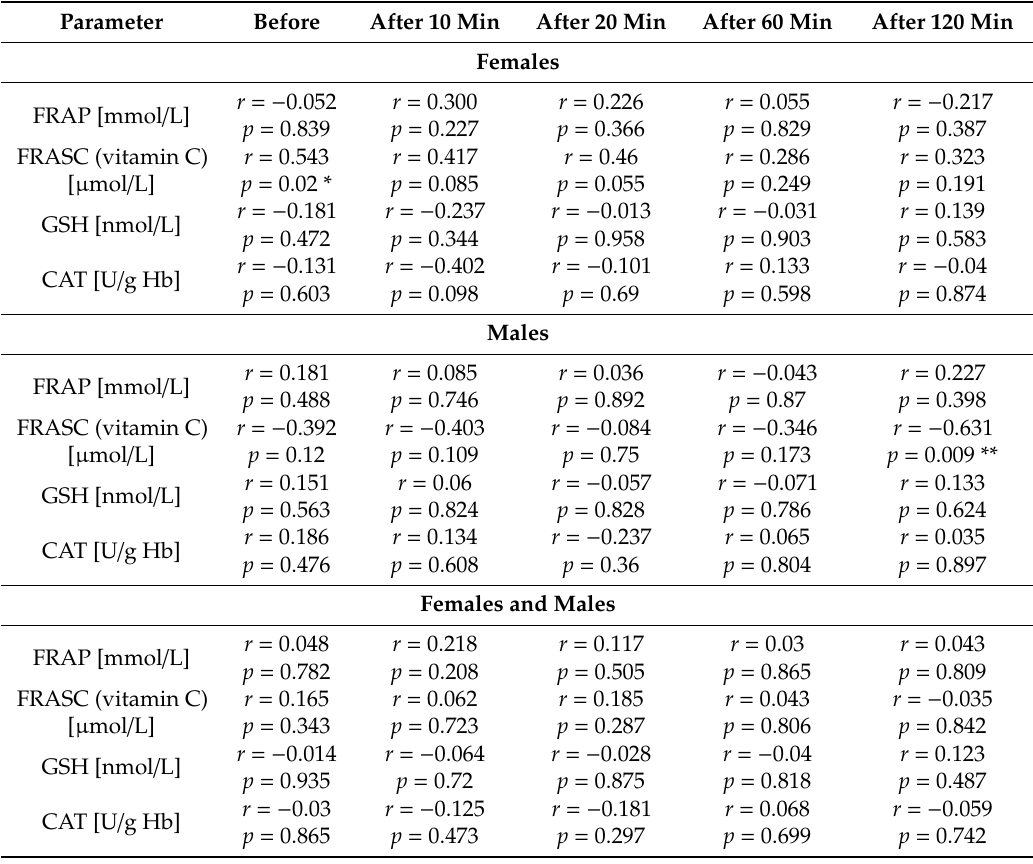
Table 6. The e ff ect of age on mean CAT, GSH, FRAP and FRASC values at di ff erent time points of the CT scan: before the test and 10, 20, 60 and 120 min after the